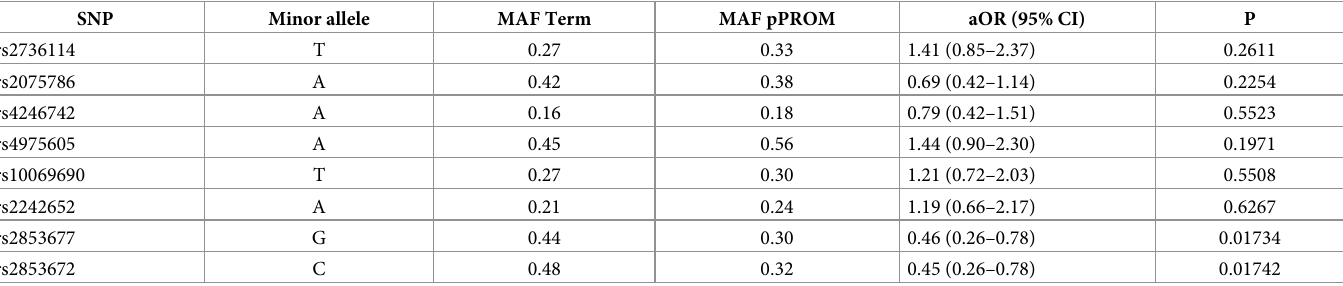
Table 7. Logistic regression results for fetal single locus allele frequencies among cases and controls and association with preterm premature rupture of membranes.